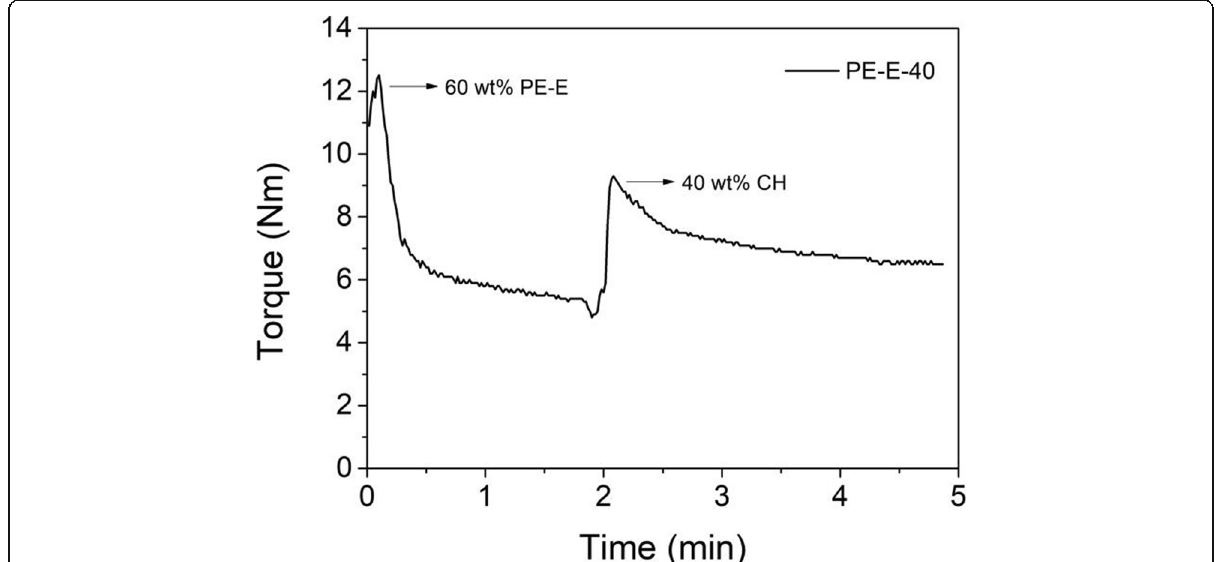
Fig. 3 Mixing sequence of PE-E-40